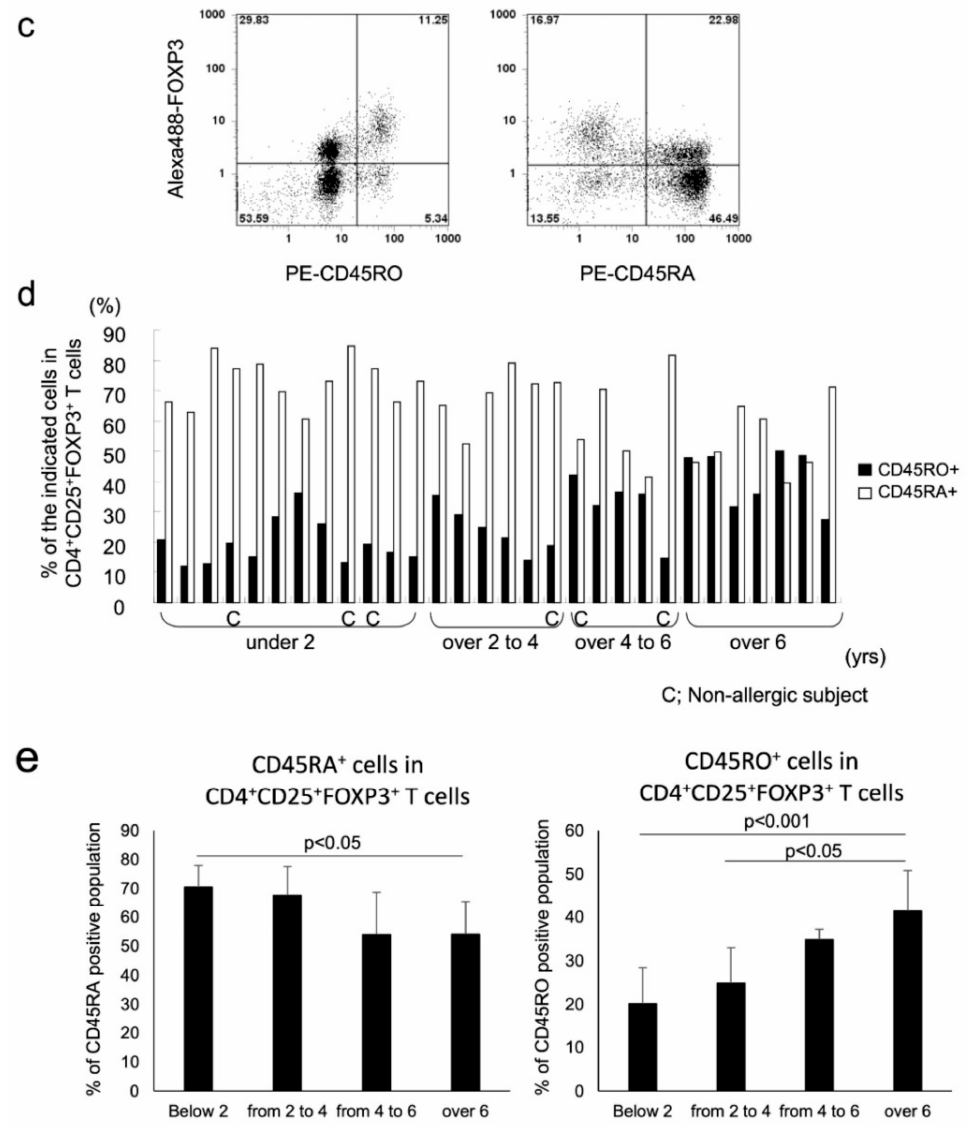
Figure 1. Flow cytometric surface marker analysis of CD4 + T cells isolated from paediatric PBMCs are shown from representative cases. In total, 1 × 10 6 CD4 + cells were stained with Alexa 488- FOXP3, PE-CD25, and PC5-CD127 ( a ), or with Alexa 488-FOXP3, PC5-CD25, and PE-CD45RO ( b ). Representative flow histograms are shown. ( c ) The cells were stained with Alexa 488-FOXP3, PC5-CD25, and PE-CD45RO or CD45RA. Representative flow histograms are shown. ( d ) Results from individual paediatric subjects are plotted by bar graph. ( e ) Data from ( d ) were combined into 4 groups by age, and the difference was statistically analysed. All histograms were gated with CD25 because of the analysis of purified CD4 + T